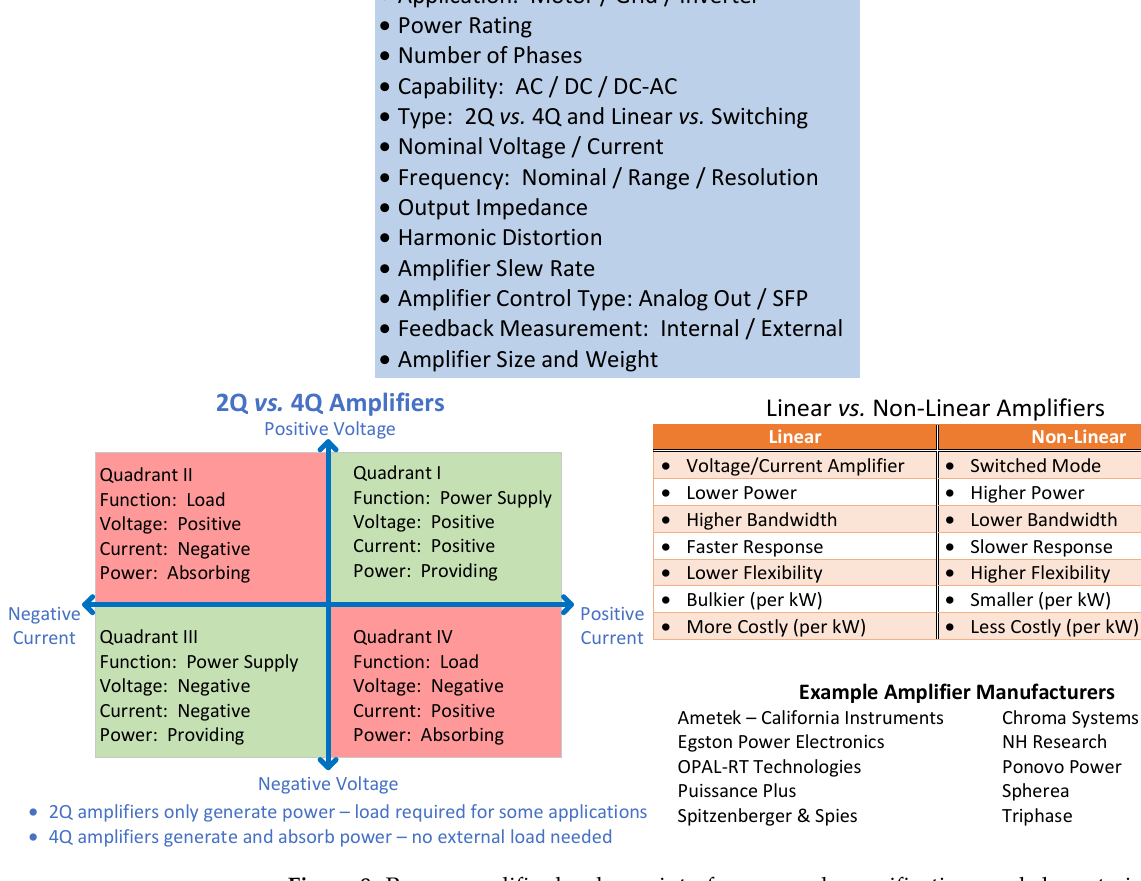
Figure 8. Power amplifier hardware interface example specifications and characteristics, adapted from [56].